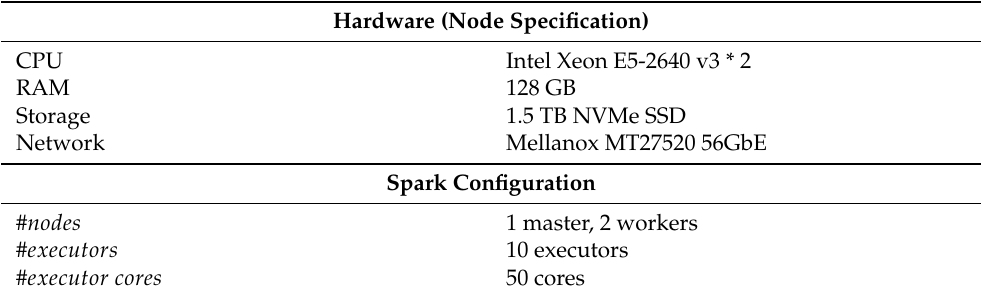
Table 2. Distributed server hardware specification and Spark configuration.